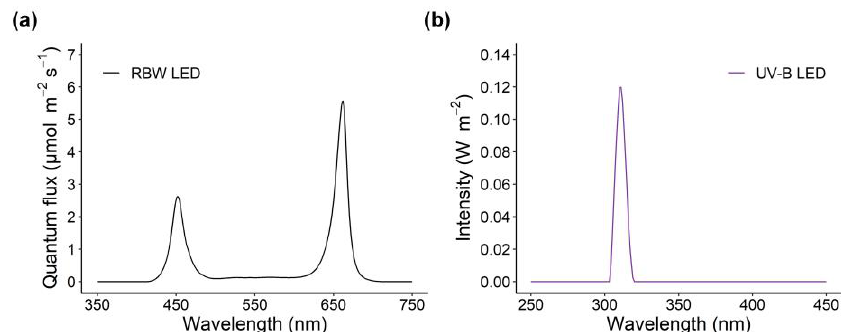
Figure A1. Light spectra of the light source. ( a ) Red, blue and white LEDs (RBW LED) at a photosynthetically active radiation of 200 μmol m −2 s −1 ; ( b ) UV-B LED with a spectrum peak at 310 nm at a dose of 1.0 W m −2 .